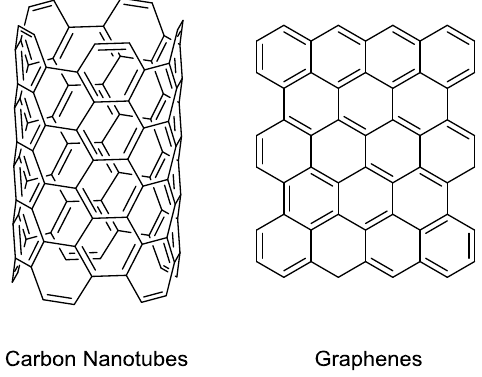
Figure 5. Schematic of carbon nanotubes and graphene.